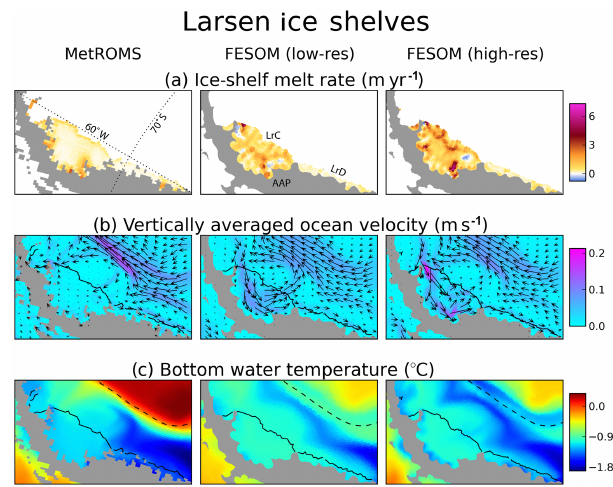
Figure 18. (a) – (c) As Figs. 11a, b, and 14b for the Larsen ice-shelf cavities. The dashed black line in panel (c) shows the 1500m iso- bath. LrC indicates Larsen C Ice Shelf, LrD indicates Larsen D Ice Shelf, and AAP indicates Antarctic